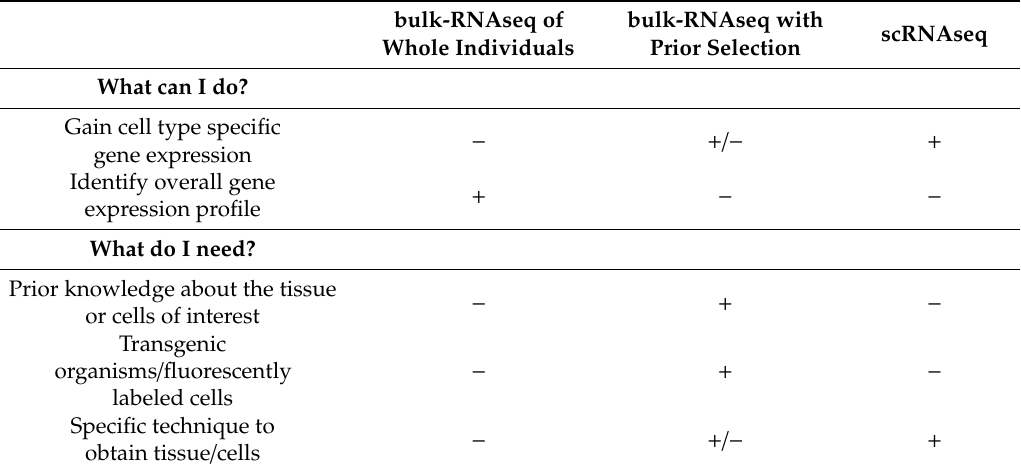
Table 2. Comparison of di ff erent RNA sequencing